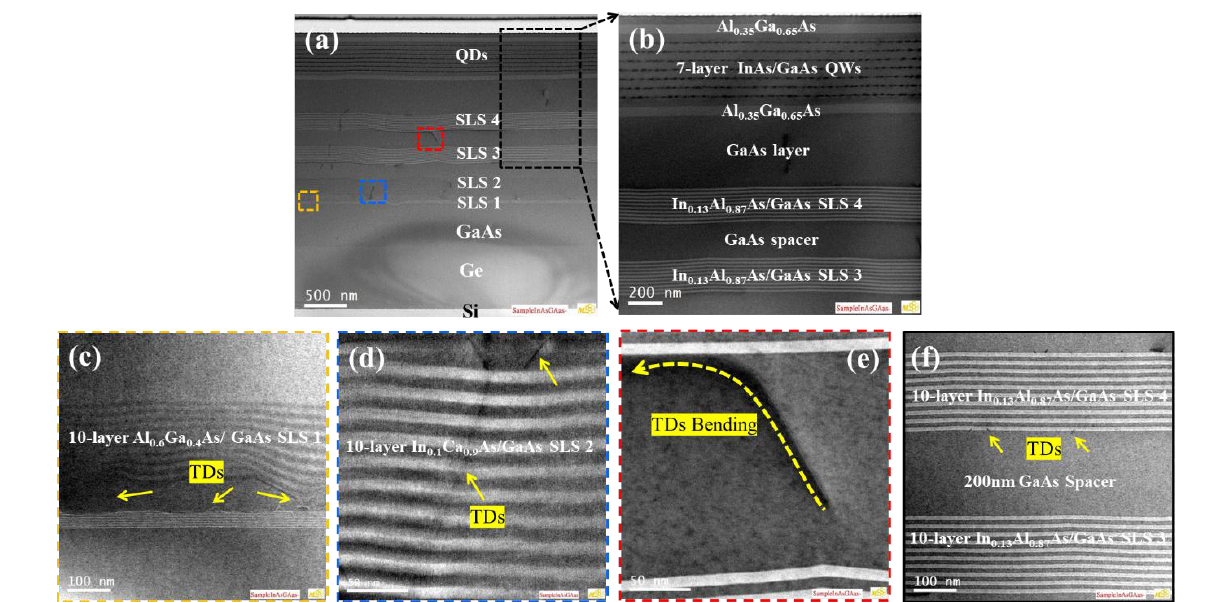
Figure 5. ( a ) Cross-sectional bright-field STEM image of seven-layer InAs QDs on the GaAs/Ge/Si substrate inserted with SLS; ( b ) close-up view of the QD region; ( c ) magnified image of the first Al 0.6 Ga 0.4 As/GaAs SLS; ( d ) magnified image of the second In 0.1 Ga 0.9 As/GaAs SLS; ( e ) Zoomed-in cross-sectional TEM images of TDs bending at the SLS interface; ( f ) Higher resolution STEM image that demonstrates the sharp interface between In 0.13 As 0.87 As and GaAs.